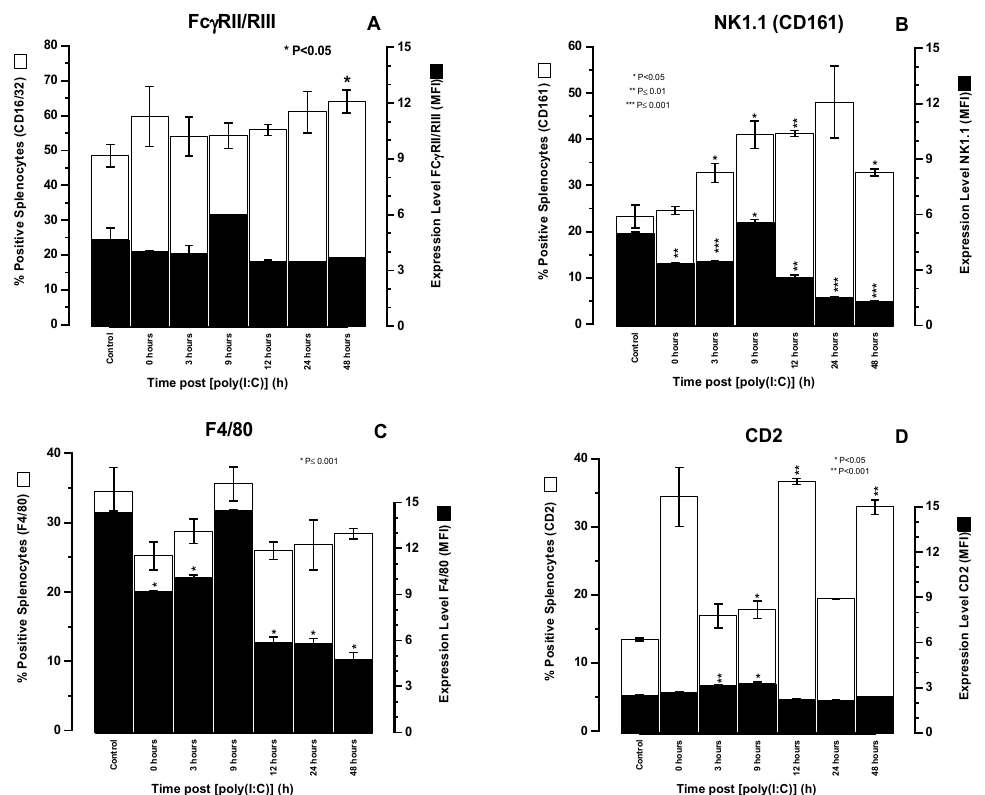
Figure 3. Percentage of SCID mouse splenocytes positive ( □ ) for cell surface FC γ RII/RIII ( A ), NK1.1 (CD161) ( B ), F4/80 ( C ), and CD2 ( D ) and their respective expression levels ( ■ ) shown as mean fluorescent intensity (MFI) at various time points following i.v. injection of 100 mg [poly (I:C)]. Error bars show standard deviations obtained from three replicate samples. Asterisks shown within individual chartlets denote the level of significant differences between read outs obtained from untreated control splenocytes and splenocytes from animals at various time points after i.v. treatment with 100 μ g [poly (I:C)].